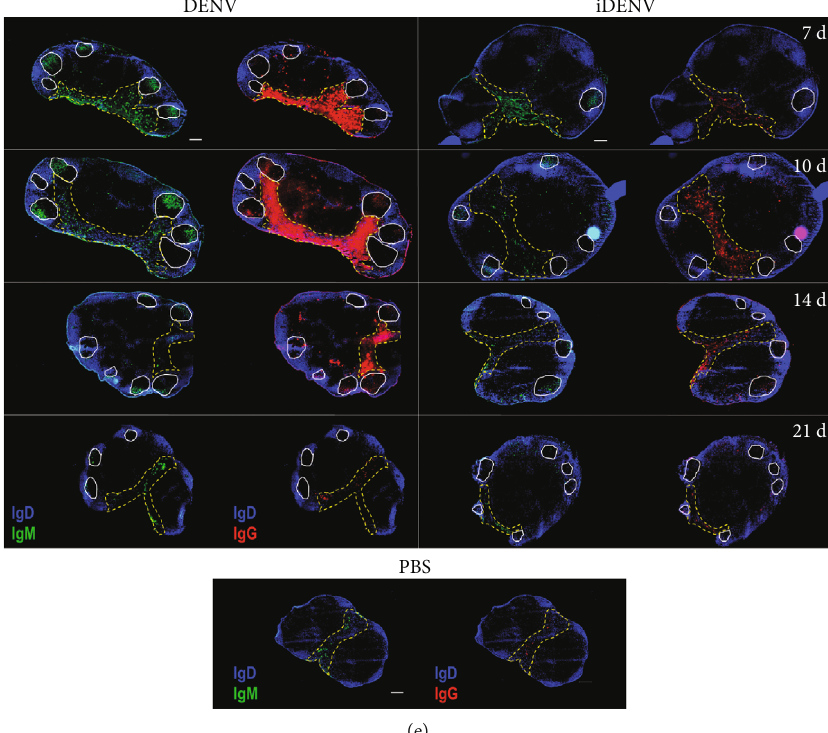
Figure 2: PCs response induced by DENV is largely dominated by IgG + class-switched cells. Class-switched PCs were analyzed by intracellular staining of IgM and IgG by fl ow cytometry in the DLN of mice at di ff erent times postcutaneous inoculation. (a) Representative fl ow cytometry contour plots of IgM + vs. IgG + PCs (CD138 + Ly6C + ) at day 7 post-DENV inoculation. Numbers represent the proportion of IgM + or IgG + cells from PCs. (b) Percentage of IgM + and IgG + PCs during the kinetic. Dotted lines represent IgM + PCs, and solid lines IgG + PCs among the groups. Number of IgM (c) and IgG (d) PCs at days 3, 7, 10, 14, and 21 p.i. (e) DLN cryosections from mice inoculated with DENV (left panel), iDENV (right panel), or PBS (bottom panel) show the distribution of IgM- (green, left) and IgG-expressing cells (red, right). GC zones and the medulla are indicated with white solid lines and yellow dotted lines, respectively. Scale bars represent 200 μ m. Data shown represent the mean ± SEM and are representative of four independent experiments with two mice per group per time point and histology results from two experiments with four mice per group per time point. Two-way ANOVA with the Bonferroni post hoc test were used for the statistical analysis. ∗ P < 0 : 05 , ∗∗ P < 0 : 01 , ∗∗∗ P < 0 : 001 , and ∗∗∗ P < 0 : 0001 . Asterisks above the DENV line (solid red line) represent statistical di ff erences against iDENV, and asterisks below the iDENV line (solid blue line) represent statistical di ff erences against the PBS control